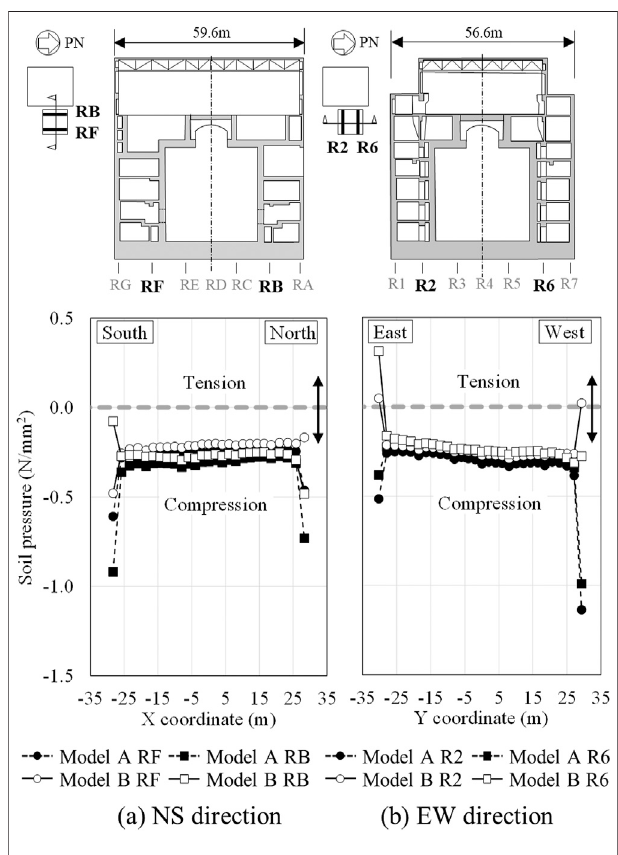
FIGURE 14 | Soil pressure characteristics at time of maximum tension acting beneath